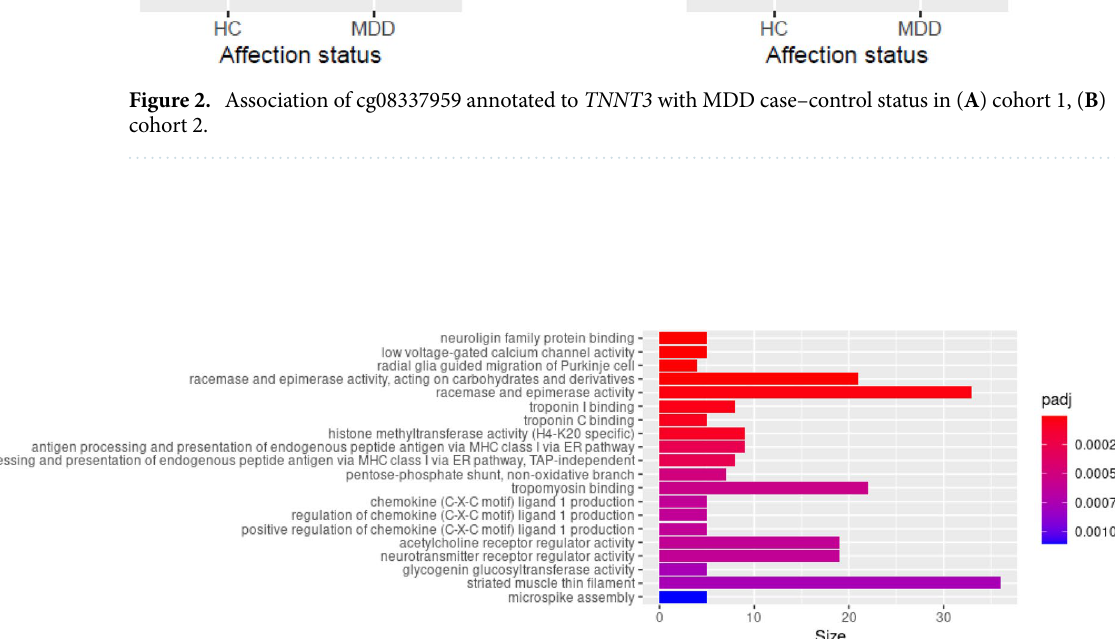
Figure 3. Enriched gene sets from the GO database (min gene set size = 4) among DMP associated with MDD case status with a p value less than 1 × 10 –4 in the EWAS